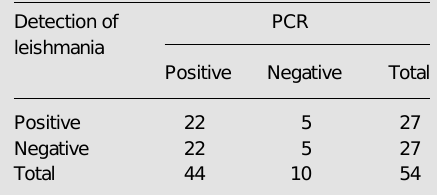
Table 1. Comparison of the PCR results and the histopathological detection of leishmania in 54 cases of American cutaneous leishmaniasis. Detection